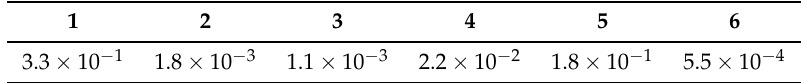
Table 2. MSE for the parameter sets from the Table 1 computed with the penalty term